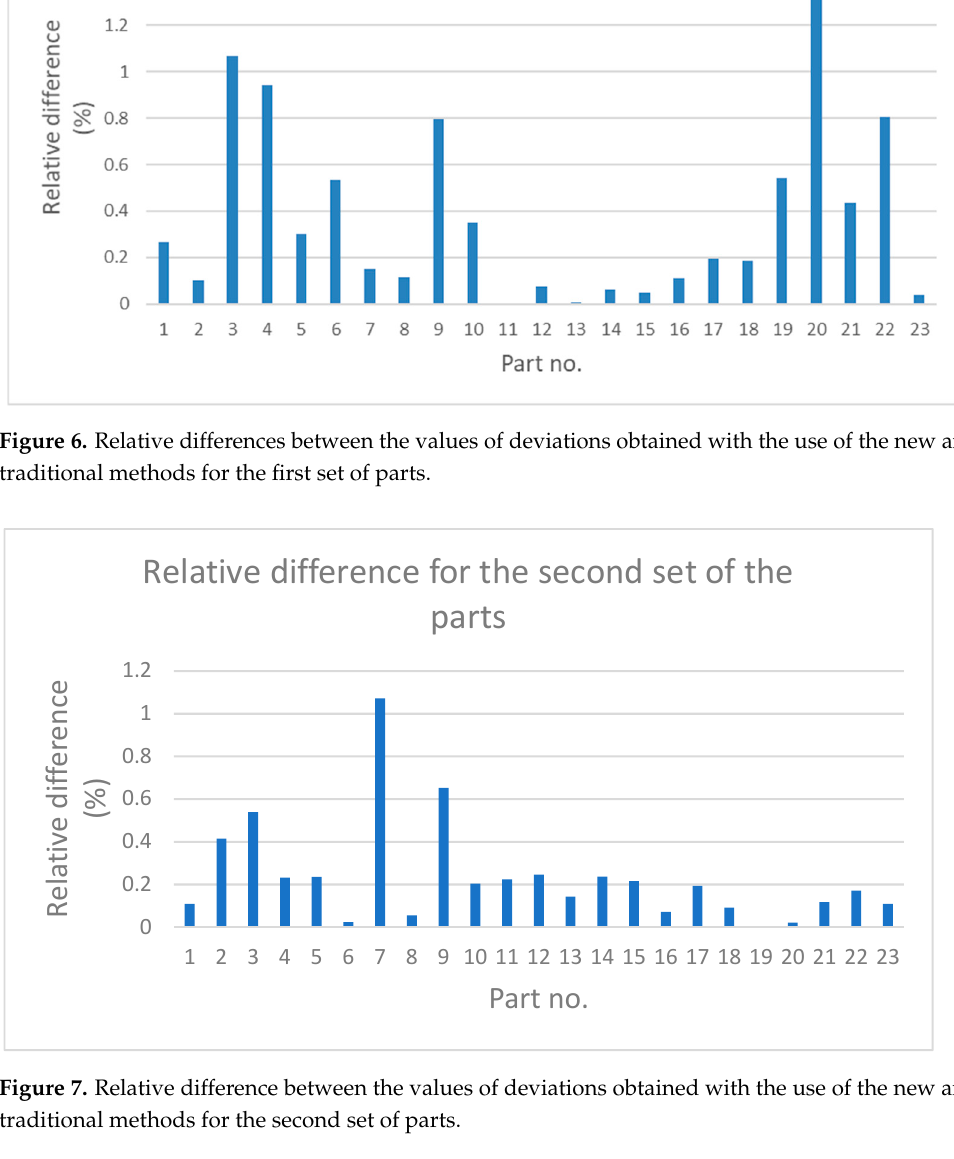
Table 3. Statistical parameters of the relative difference between results obtained by new and tra- ditional methods for the first set of parts.